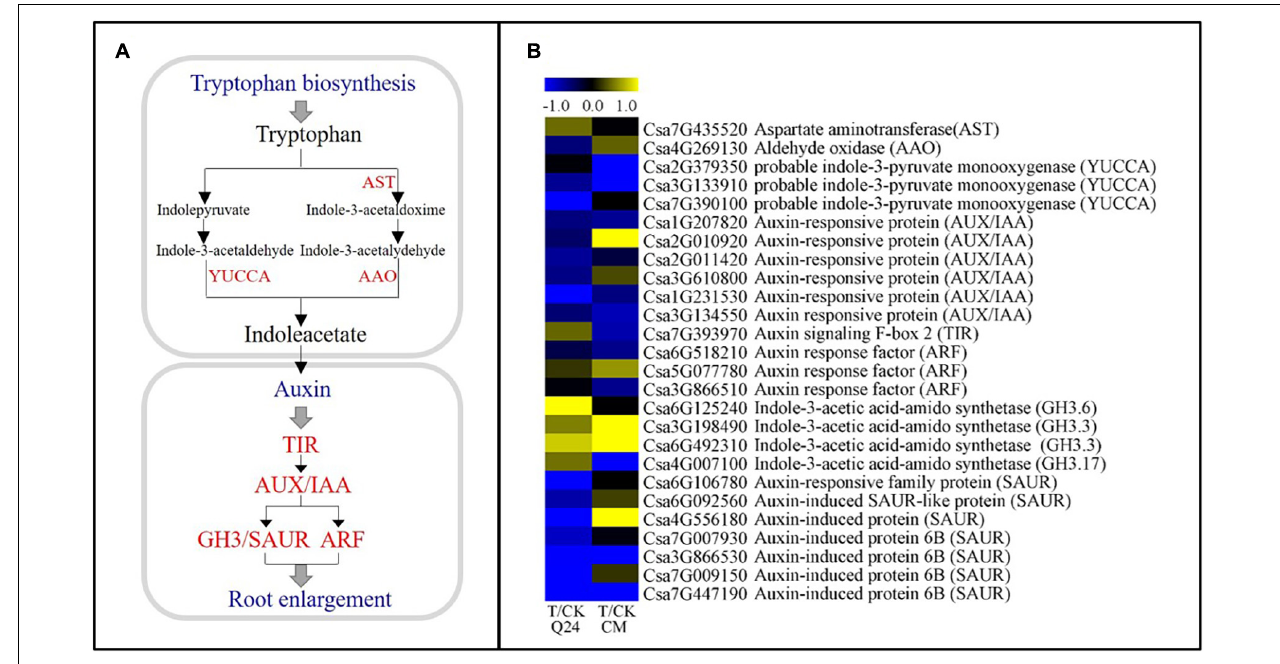
FIGURE 6 | IAA biosynthesis and signal transduction pathways and heat map of differentially expressed genes in Q24 and CM. (A) IAA biosynthesis and signal transduction pathway; (B) the heat map showed the value of the log2FoldChange of genes compared with that of the control in IAA pathway. Yellow indicated up expression and blue indicated down